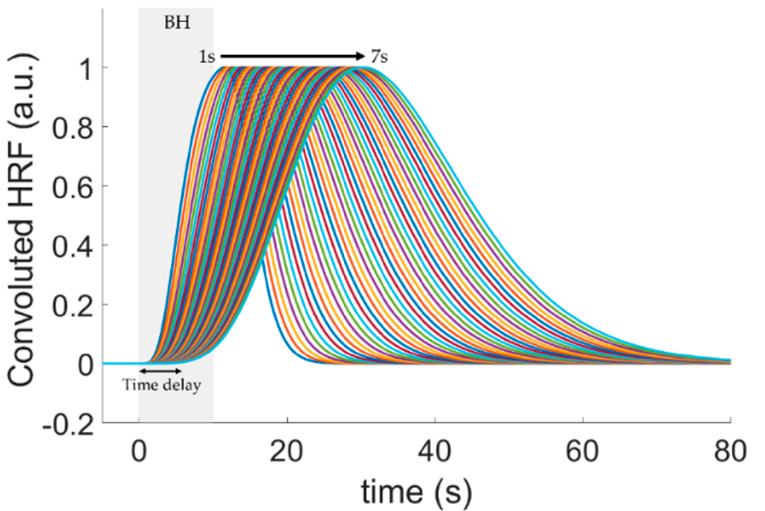
Figure 2. Hemodynamic response function (HRF) models used in the proposed adaptive GLM (aGLM) analysis. By varying the dispersion time of the HRF basis function ( τ h in Equation (1)), we could model differences in the transit time of the cerebrovascular response to breath − holding in patients diagnosed with carotid artery stenosis (CAS). The HRFs with different delays (solid curves) were obtained by convolving the HRF basis function with a boxcar representing the breath-holding challenge (BH). The resulting HRFs were characterized by their delayed onset, ranging from 1 s to 7 s. The median and interquartile range (IQR) of the estimated delays representing the slower dynamics across all channels that exhibited a response to breath-holding in each hemisphere were used for hemispherical analysis in every participant. For time